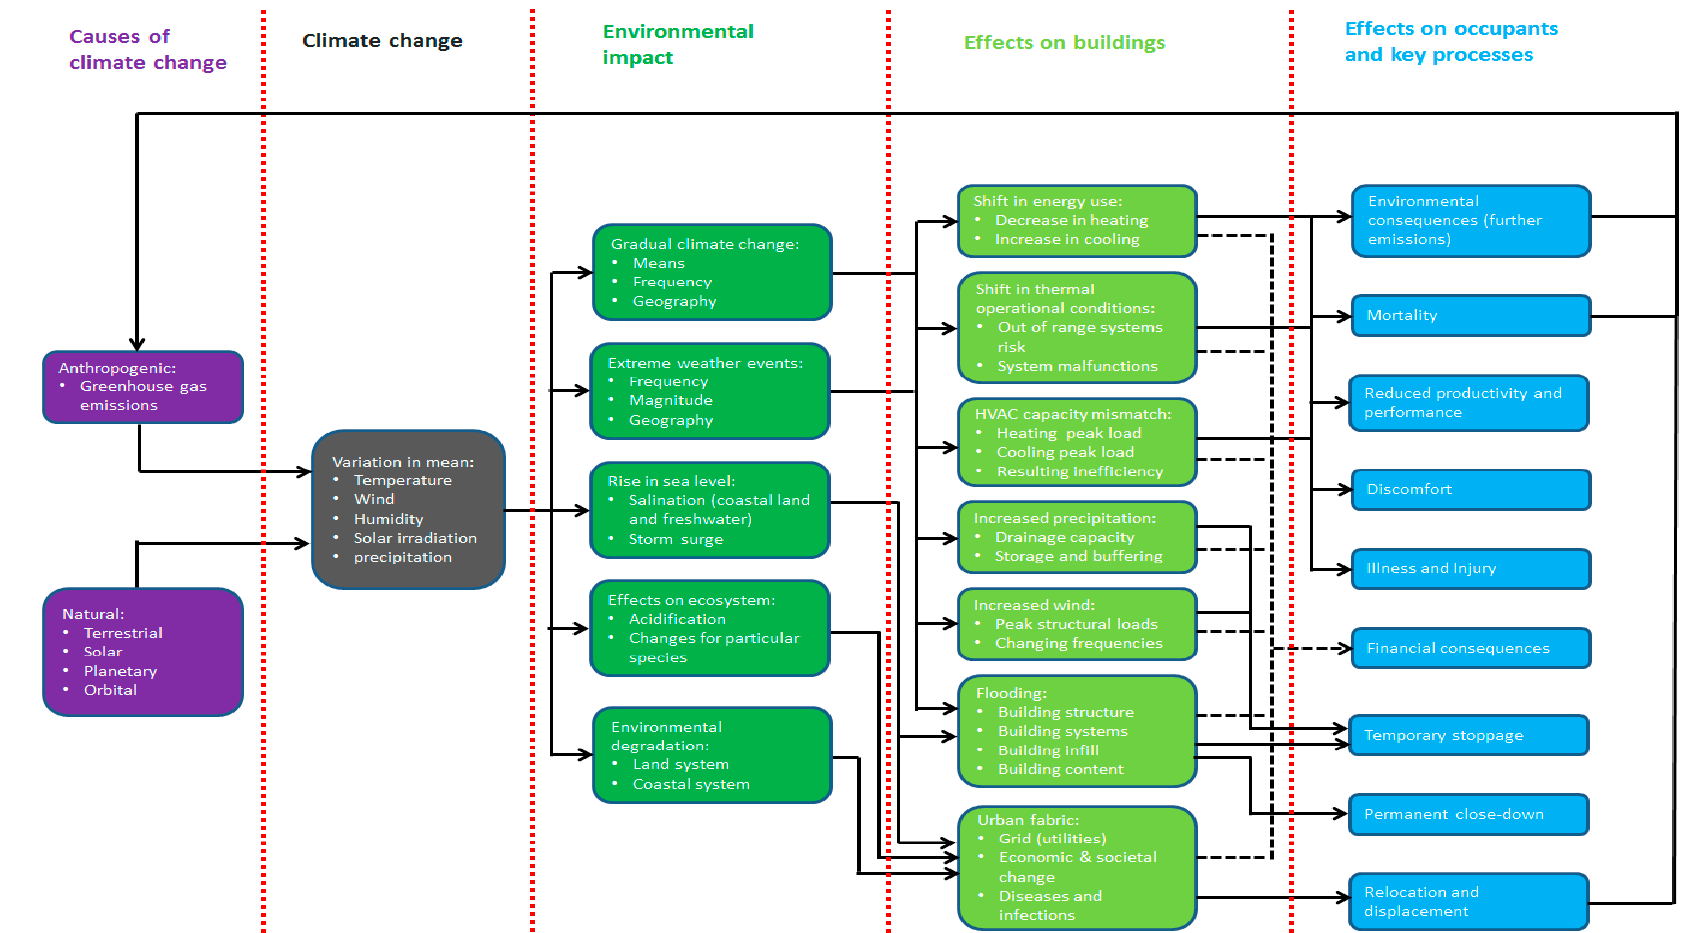
Figure 7. Interactions between buildings, climate change and subsequent potential effects on building occupants and the environment. The figure is based on a schematic overview by de Wilde and Coley [51]), but expanded to elaborate on the cyclic interactive nature .